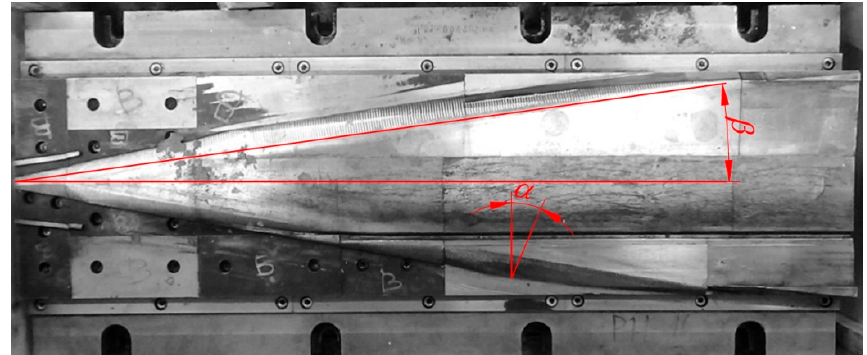
Figure 3. One of the wedges used in the test rolling of the harrow tooth preform.